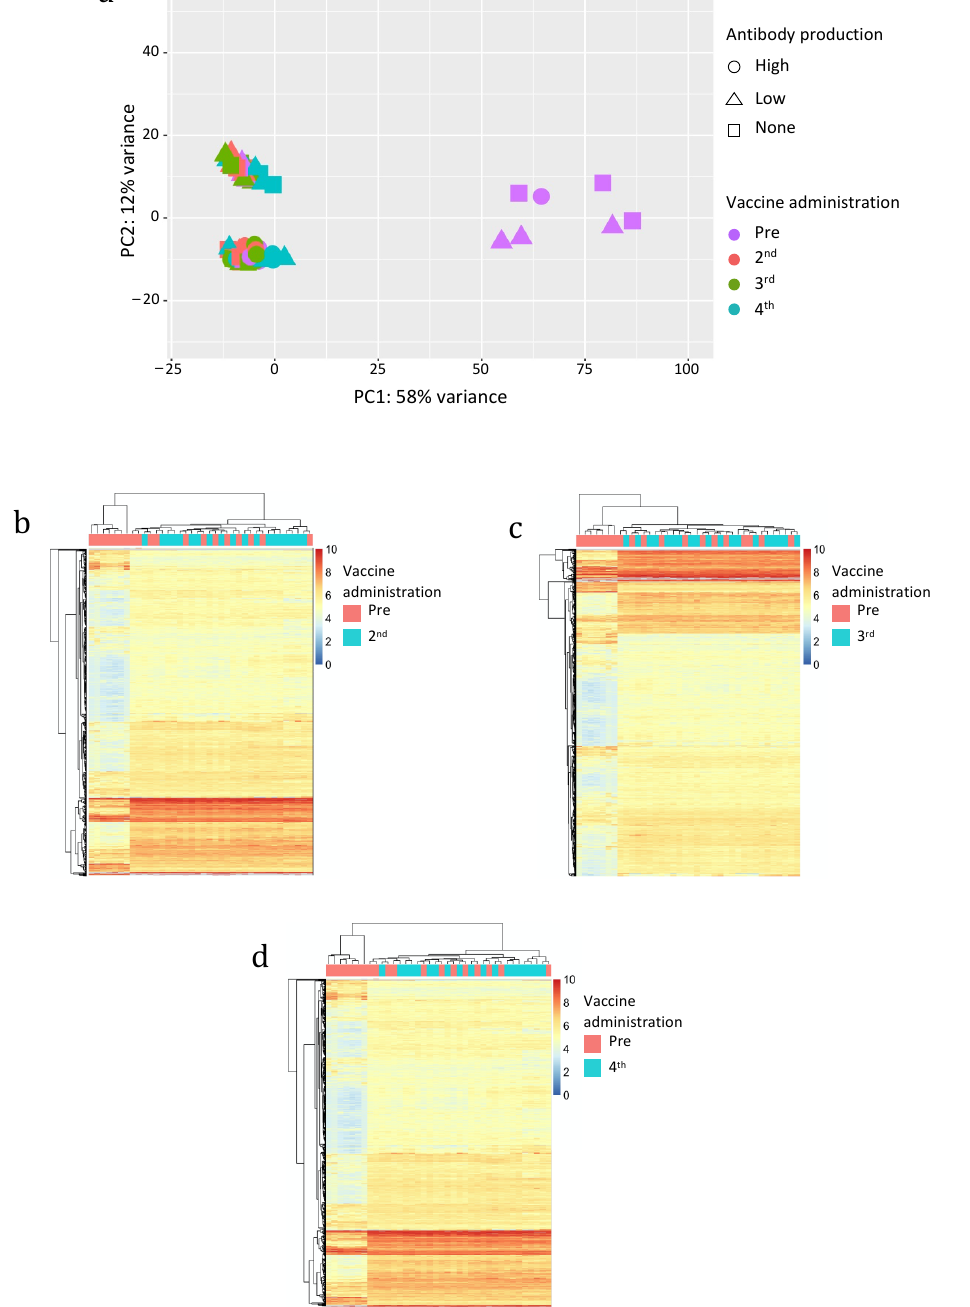
Figure 3. Principal Component Analysis (PCA) ( a ) and heatmaps of the overall similarity between pre-vaccinated and samples after the 2nd ( b ), 3rd ( c ), and 4th ( d ) vaccine administration. PCA was performed on rlog-normalized hervgdb4 fragments expression data ( a ). The PC1 explains 58% of the overall variance. Heatmap. Hierarchical clustering was performed on the top 1500 hervgdb4 fragments with the highest standard deviation (rows) based on rlog-normalized counts in each sample (columns). rlog-normalized counts are color-scaled from blue (minimum) to red (maximum). Correlation distance measure has been used in columns’ clustering. Samples are annotated by vaccine administration (red pre-vaccinated and light blue after the 2nd, 3rd, and 4th administration).